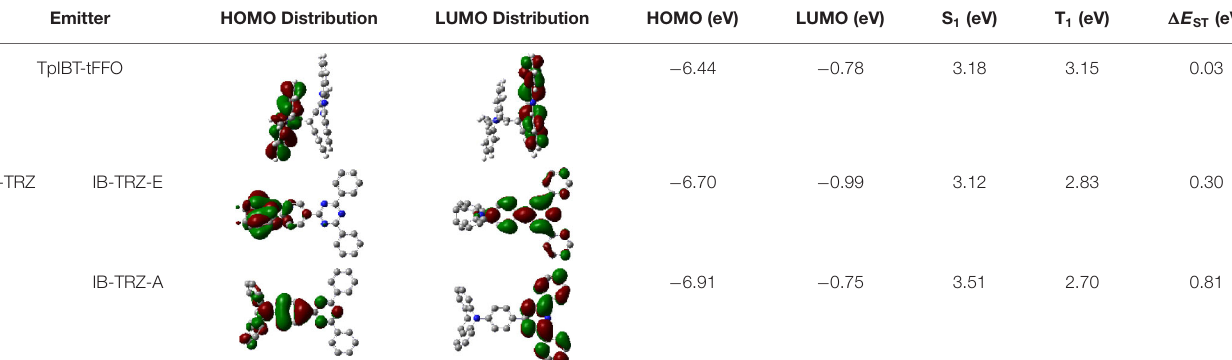
TABLE 1 | Distributions of the HOMO and LUMO, energy levels of HOMO, LUMO, 1 E ST , S 1 , and T 1 of TpIBT-tFFO and IB-TRZ calculated at LC- ω PBE/6-31 + G(d). Emitter HOMO Distribution LUMO